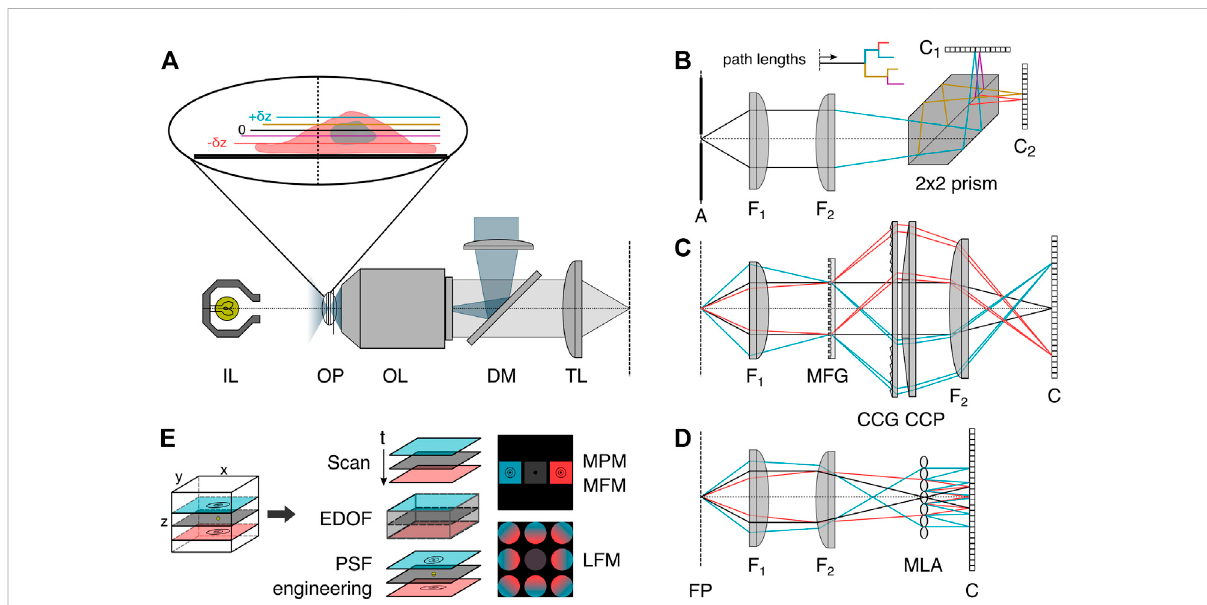
FIGURE 2 Volumetric image splitting. (A) Conventional fl uorescence epi-illumination and white light microscope with focal plane indicated as 0, and relative axial position changes ± δ z indicated in color blue (+) and red ( − ). (B) In a variant of MPM, a refractive image splitting prism [10] separates the convergent detection beam onto two cameras, via total internal re fl ection and a beam-splitting interface on the main diagonal. Inset: indication of the different path lengths corresponding to different axial object-side positions. (C) In MFM, a multifocus grating (MFG) splits the incident light into several diffraction orders associated with different degrees of defocus, which are subsequently chromatically corrected by a blazed grating (CCG) and prism (CCP) and focused with lateral displacement on the detector [21]. (D) In light fi eld microscopy, a microlens array (MLA) is placed at the intermediate image plane, and a sensor is positioned behind it. Each microlens records a perspective view of the object. (E) Schematics of selected volumetric imaging methods discussed in the introduction. EDOF: extended-depth-of- fi eld, PSF: point spread function, MPM: multiplane microscopy,MFM:multifocusmicroscopy,LFM:light fi eldmicroscopy,OP:objectfocalplane,OL:objectivelens,IL:whitelightsource,DM:dichroic mirror, TL: tube lens, A: aperture fi eld stop, FP: Fourier plane, F 1 : Fourier lens, F 2 : focusing lens, C i : camera, 2 × 2 prism: refractive image